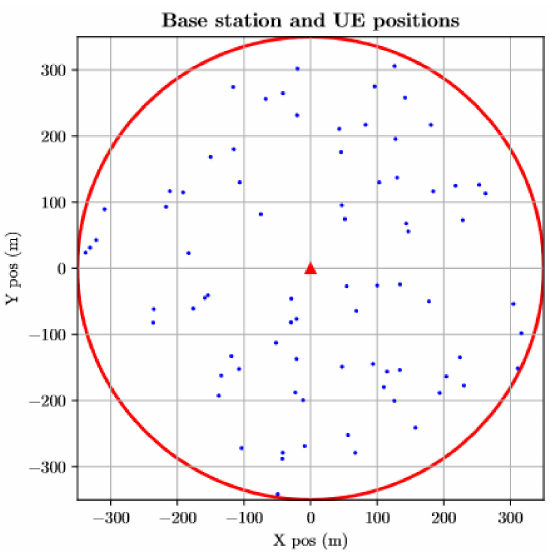
Figure 9. Population density graph for 78